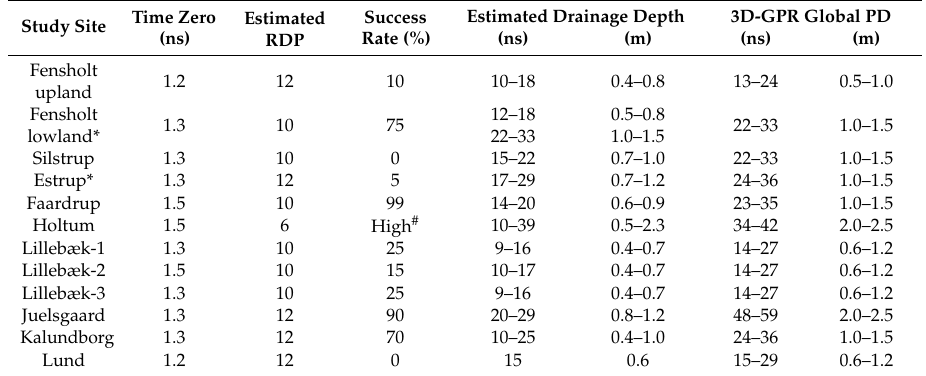
Table 2. Summary of the time zero, estimated relative dielectric permittivity (RDP), success